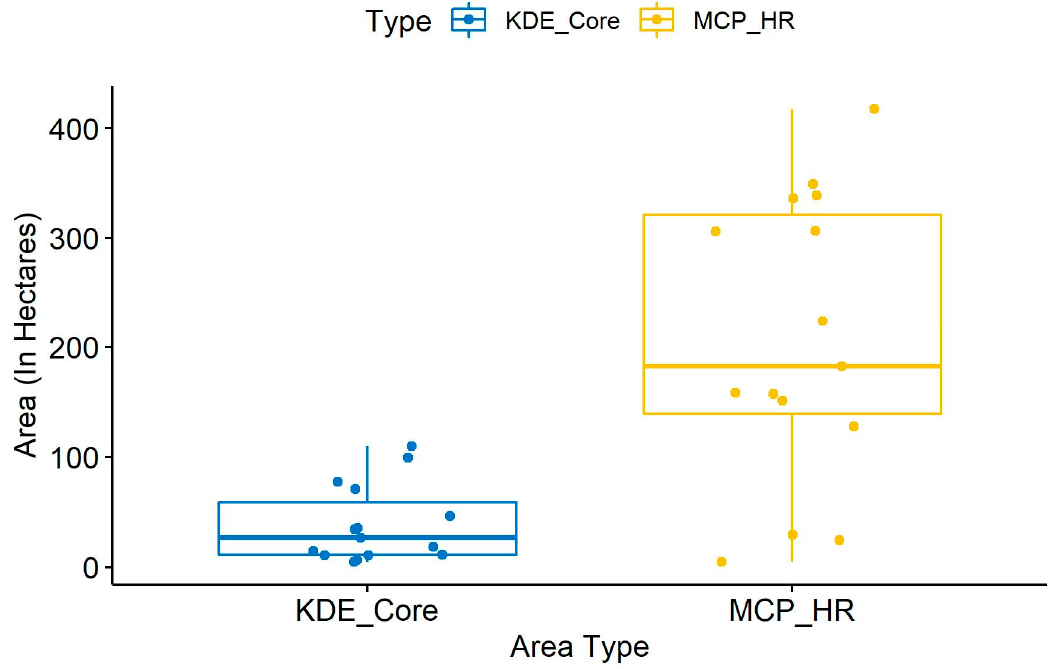
Figure 12. A comparison between KDE-derived core areas and MCP-derived home range areas show statistically significant differences ( p = 0.00018) between the core areas and home ranges of the male and female leopards.